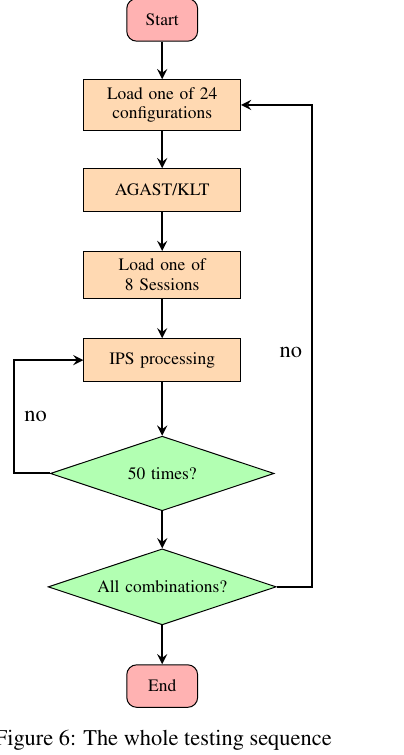
Figure 6: The whole testing sequence